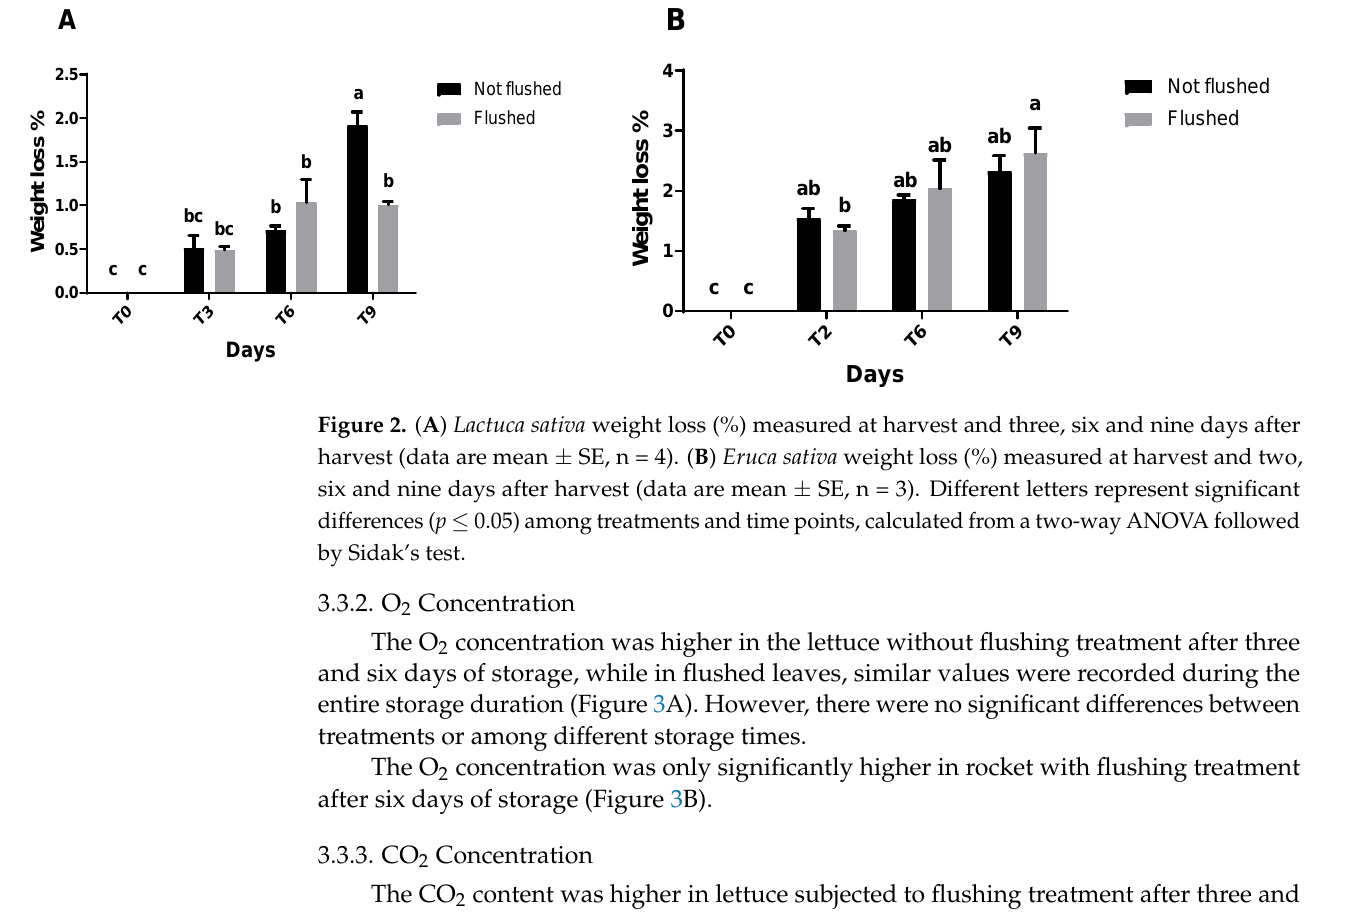
9 of 15 Figure 1. ( A ) Nitrate content measured in Lactuca sativa at harvest and three, six and nine days after harvest (data are mean ± SE, n = 4). ( B ) Nitrate content measured in Eruca sativa at harvest and two, six and nine days after harvest (data are mean ± SE, n = 4). Different letters represent significant differences ( p ≤ 0.05) among treatments and time points, calculated from a two-way ANOVA followed by Sidak’s test. 3.3. Weight Loss and Gas Content Determination in the Package Headspace 3.3.1. Weight Loss Lettuce leaves harvested from the 48 h flushing treatment maintained their weight during storage, while non-treated leaves showed higher weight loss percentages,